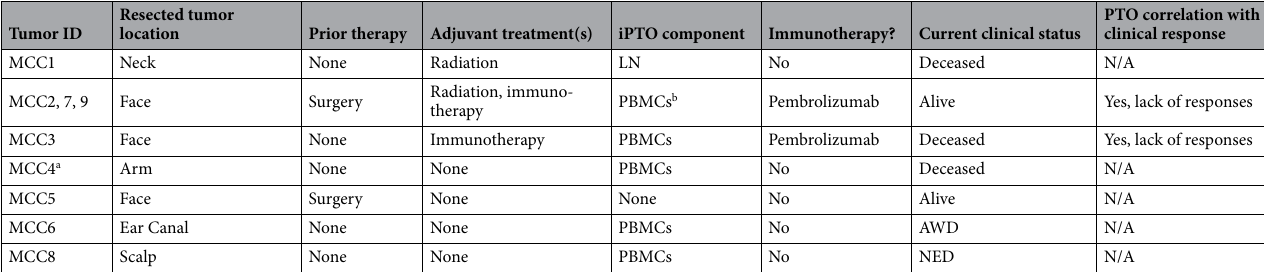
Table 1. Patient demographics, prior treatments, tumor characteristics, and PTO correlation. MCC2, 7 and 9 were from the same patient. AWD alive with disease, LN lymph node, PBMCs peripheral blood mononuclear cells, NED no evidence of disease, N/A not applicable. a Only tumor where PTOs were not successfully fabricated. b All 3 tumors iPTO immune components were from